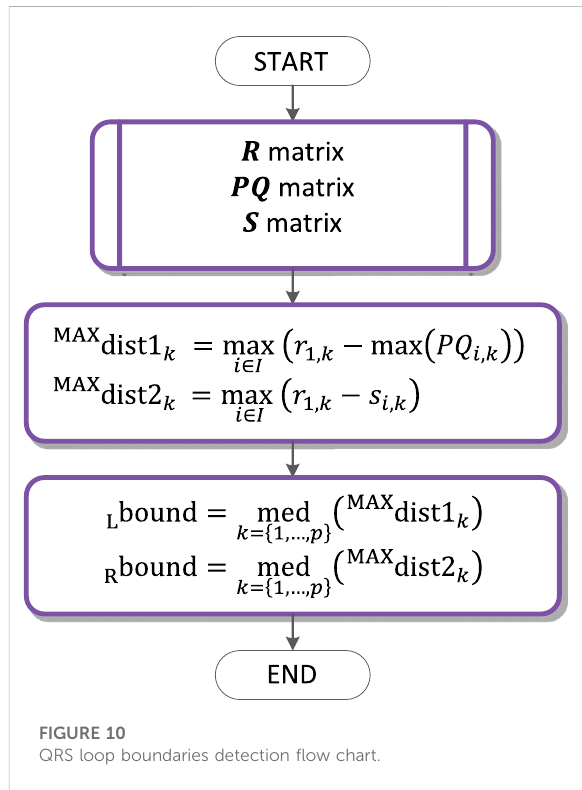
FIGURE 10 QRS loop boundaries detection fl ow chart.